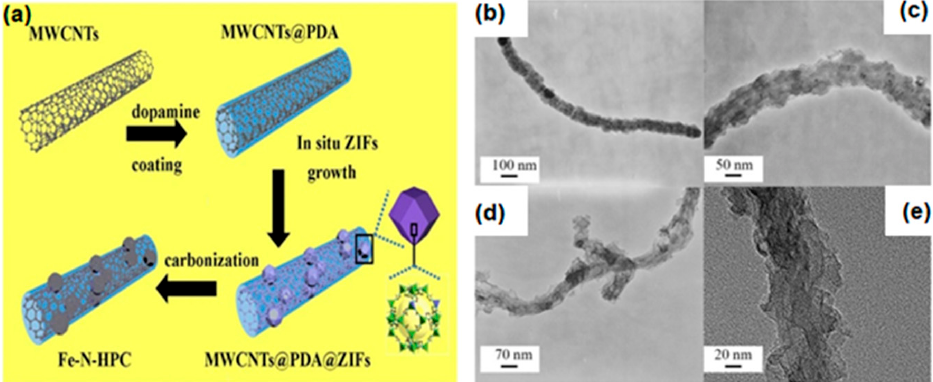
Figure 7. ( a ) Schematic illustration of the synthesis for Fe-N-HPC composites; TEM images of ( b , c ) MWCNTs@PDA@ZIFs and ( d , e ) Fe-N-HPC-900. Copyright Springer-Verlag GmbH Germany, part of Springer Nature 2019